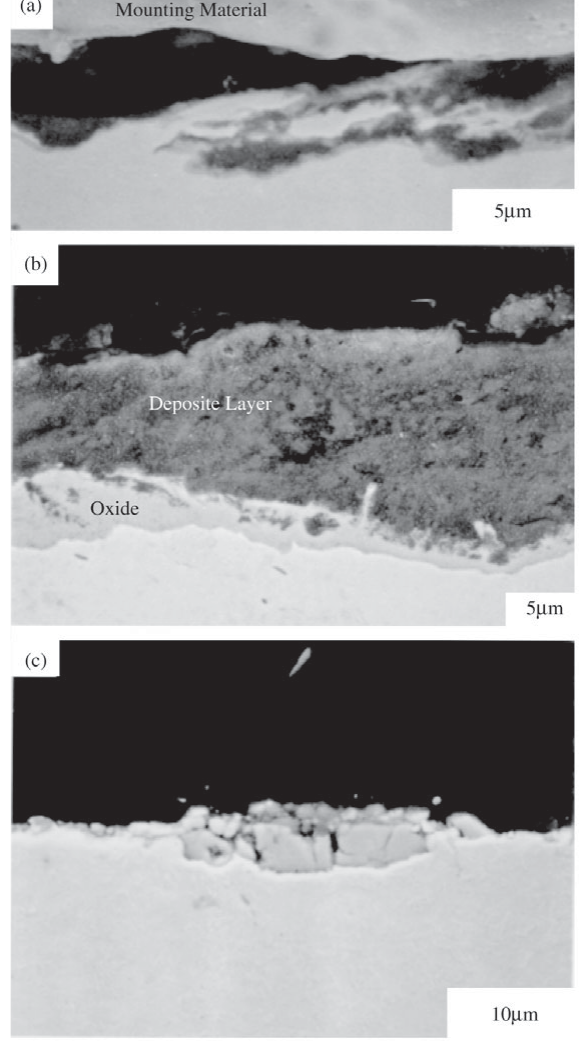
Figure 5. Backscattered SEM images of cross sections from maxi- mum wastage regions on specimens tested with batch 1 sand at (a) 300 °C, low dust condition; (b) 450 °C, high dust condition; and (c) 500 °C, low dust